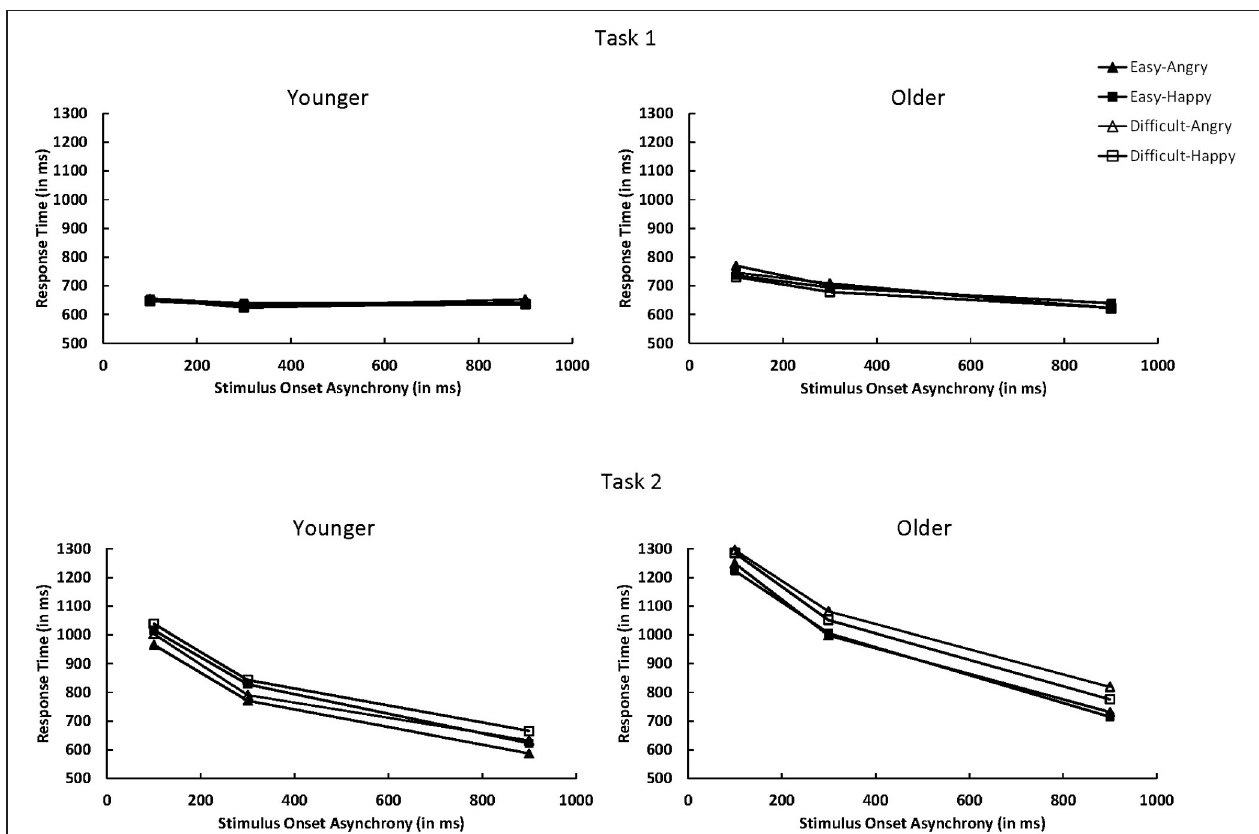
FIGURE 3 | Mean response time for Task 1 and Task 2 as a function of age group (younger vs. older), Task 2 difficulty (easy vs. difficult), Task 2 emotion (angry vs. happy), and SOA (100, 300, or 900ms). SOA, stimulus onset